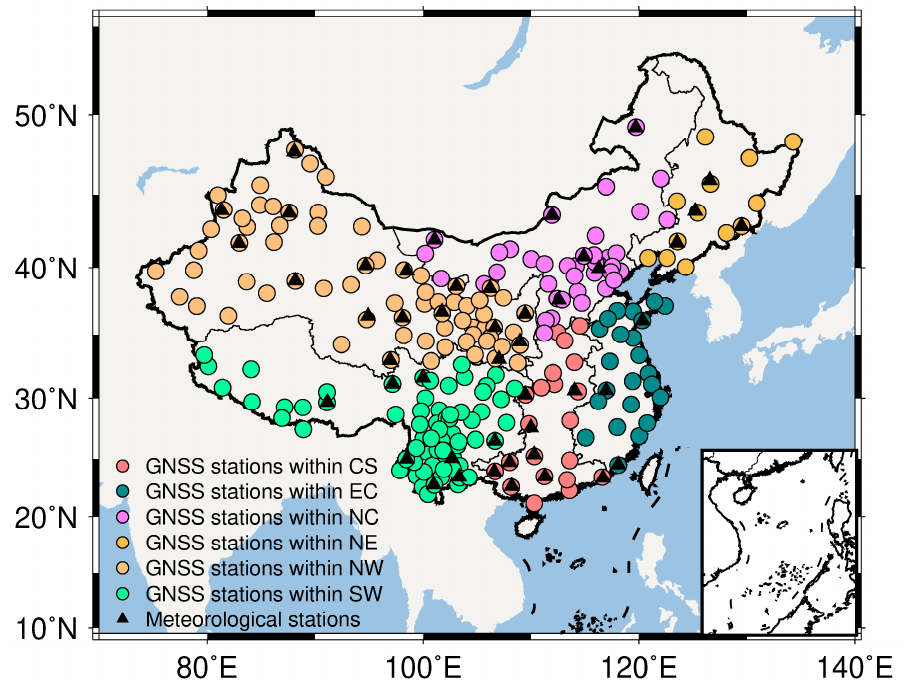
Figure 1. The geographical distribution of GNSS stations (dots) and the adjacent meteorological stations (black triangles) in mainland China. Different colors represent stations located in different geographical regions.